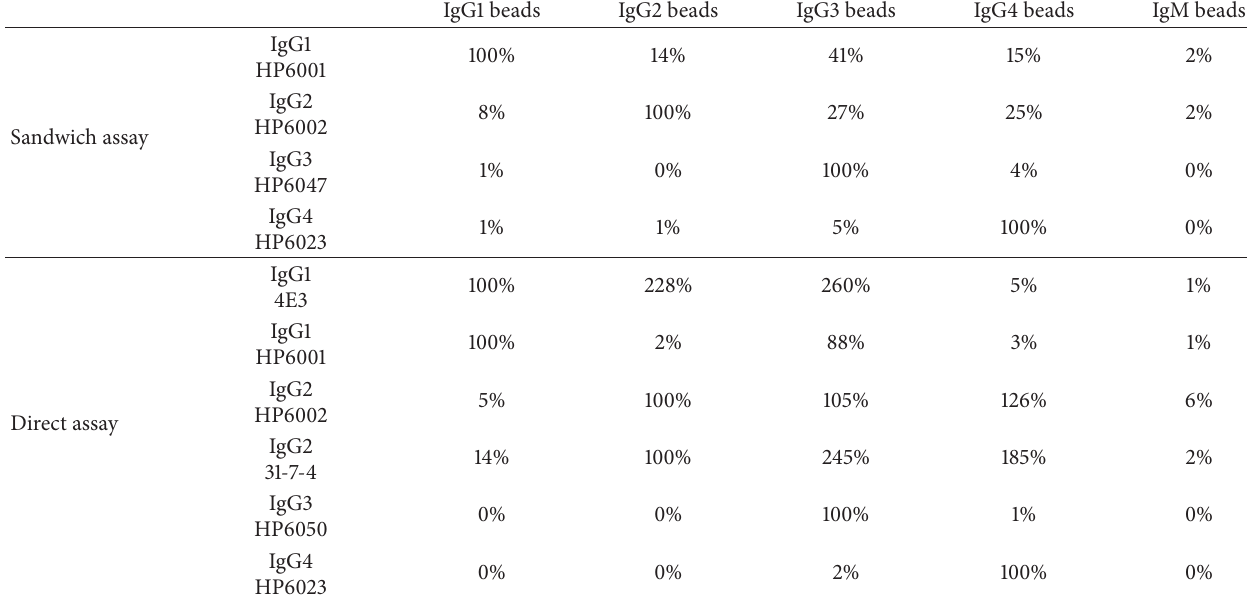
Table 4: Comparison of direct and sandwich IgG subclass